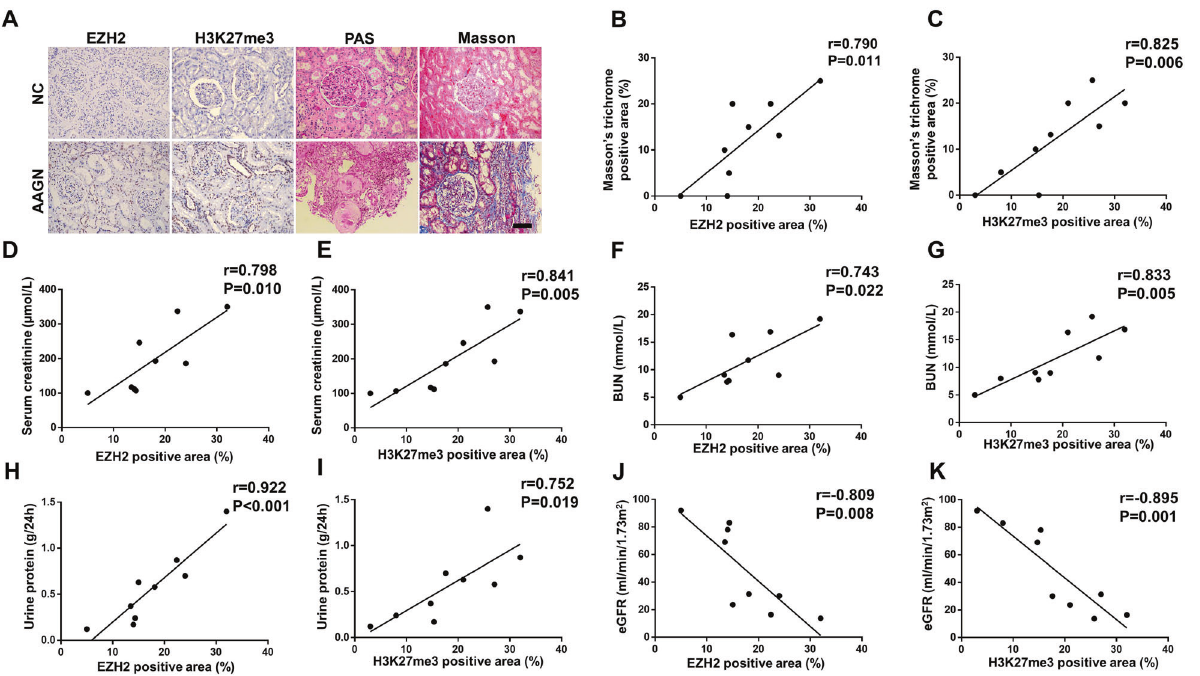
Fig. 1 EZH2 is highly upregulated in kidney of patients with ANCA-associated glomerulonephritis and correlated positively with Masson ’ s trichrome-positive area and negatively with eGFR. A The photomicrographs of EZH2 and H3K27me3 immunohistochemical staining, PAS, and Masson ’ s trichrome staining in normal paracancerous tissue from renal carcinoma patient (normal control, NC) and renal cortical tissue from patients with ANCA-associated glomerulonephritis (AAGN). B – K The correlation between positive areas of EZH2 as well as H3K27me3 and Masson ’ s positive area, serum creatinine, blood urea nitrogen (BUN), urine protein, and estimated glomerular fi ltration rate (eGFR) in all AAGN patients ( n = 9). Data were expressed as means ± SEM. * P < 0.05; ** P < 0.01; *** P < 0.001; **** P < 0.0001. N.S., statistically not signi fi cant, with the comparisons labeled. All scale bars = 50 μ